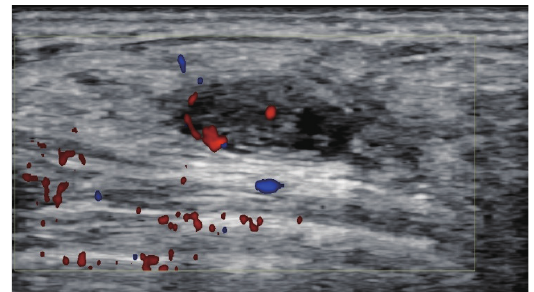
Figure 5 Color Doppler examination of recurrent mass revealed a few blood flow signals within the nodule. Surgical pathology confirmed the lesion as low to severe malignant lobular